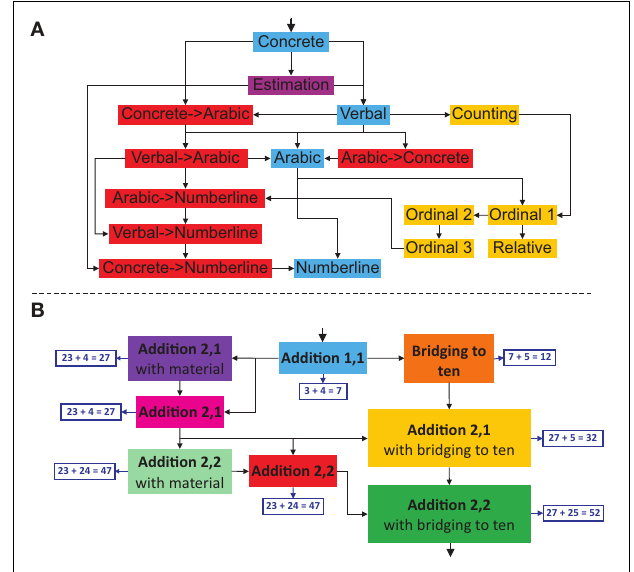
FIGURE 3 | Extract of the skill net. Number representation skills from 0 to 100 (A) . Addition skill net in the number range 0–100 with example tasks (B)